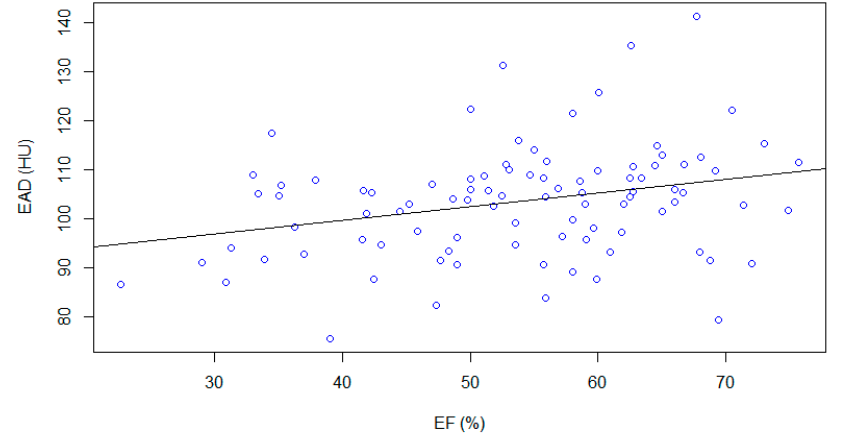
Figure 4. EF values plotted with EAD. A positive, weak correlation was found (r = 0.29, r 2 = 0.08 p - value < 0.01).